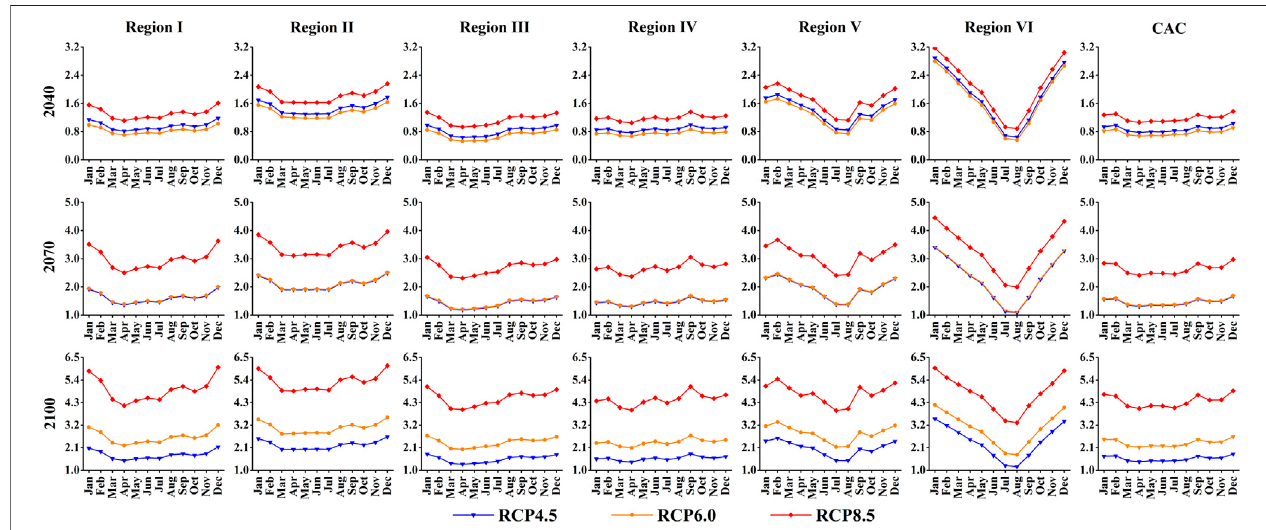
FIGURE 4 | Changes in monthly average Tmean for 2040, 2070, and 2100 with different RCPs relative to the base period 1996 – 2018 over CAC.